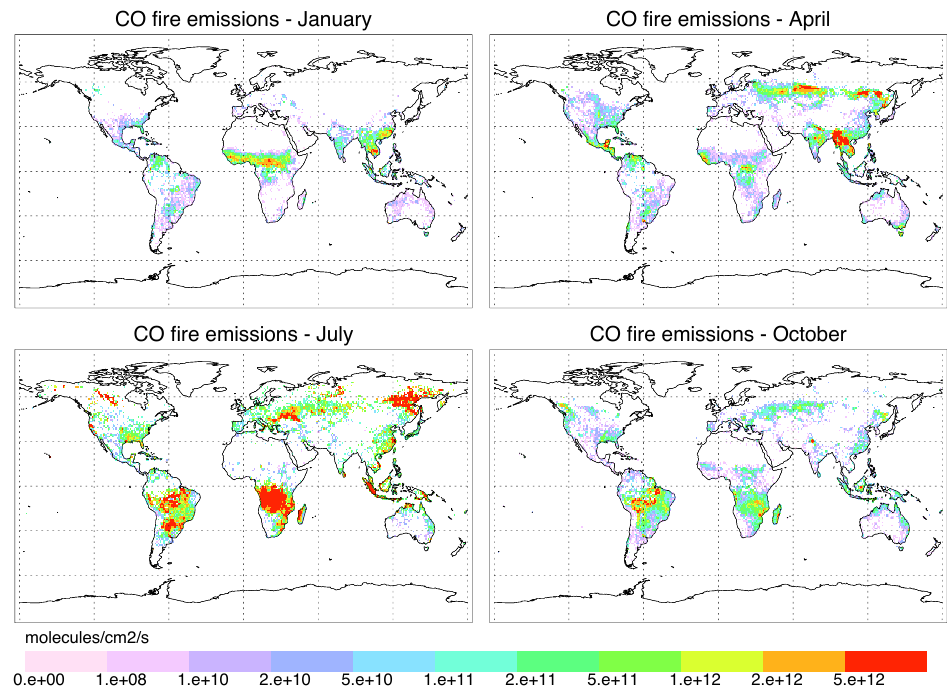
Fig. 6. Monthly CO emissions from FINNv1, gridded to 1 ◦ × 1 ◦ for January, April, July and October 2008.